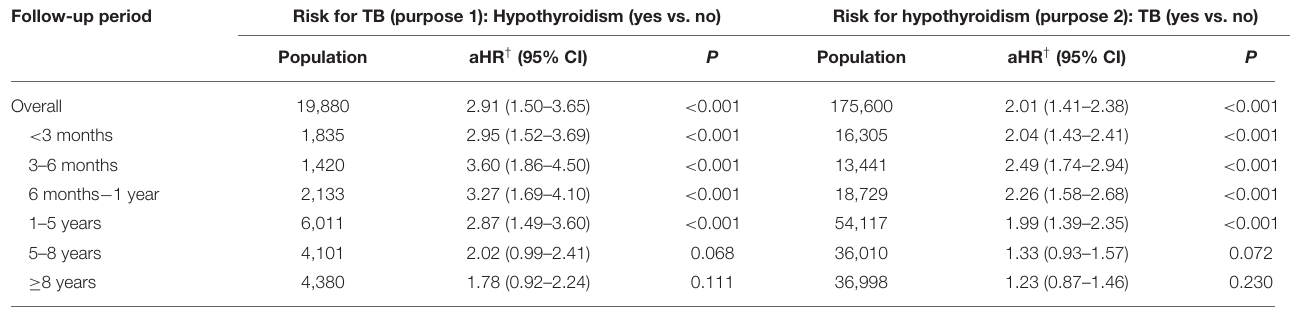
TABLE 6 | Adjusted hazard ratios of developing TB/hypothyroidism in different follow-up periods. Follow-up